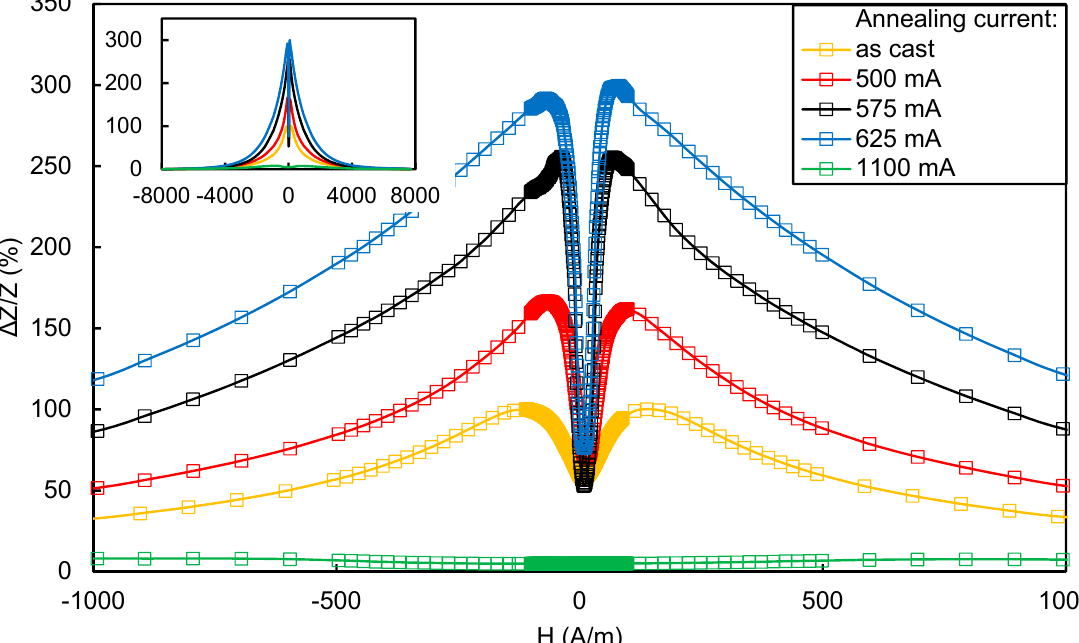
Figure 3. The impedance change characteristics ∆ Z as a function of the external magnetizing field H for samples from the amorphous alloy with the composition Co 66 Fe 4 Ni 1 Si 15 B 14 in the initial state and subjected to the process of thermomagnetic relaxation.